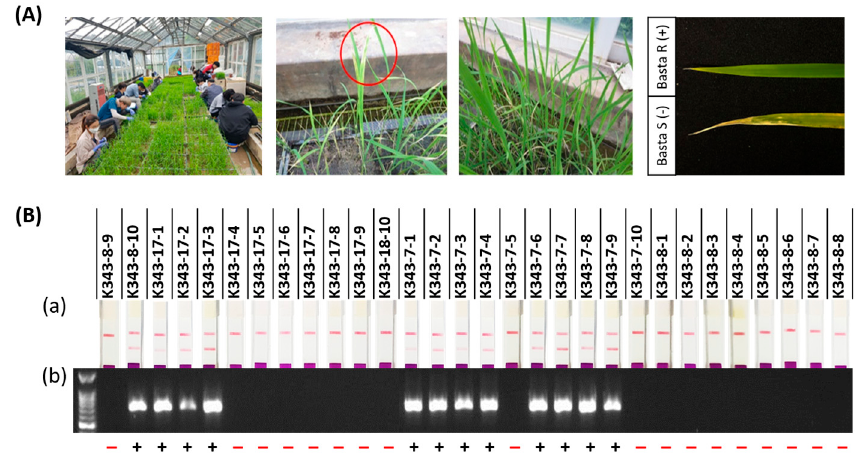
Figure 5. Selection of T-DNA-free null lines. Bar screening after glufosinate/basta treatment on leaf tip, and bar strip analysis in T 1 generation. ( A ) Screening of OsPUB7 transgenic T 0 mutants after treatment with 40 ppm basta. ( B ) Detection of the selectable marker gene using PAT/bar test strip and bar PCR: ( a ) selection of OsPUB7 null lines after PAT/bar strip test; ( b ) selection of OsPUB7 transgenic T 1 plants after bar PCR. The minus ( − ) and plus (+) signs indicate resistance to bar . Table 2. Chi-square ( χ 2 ) analysis of the genotypes with bar screening from OsPUB7 T 1 plants.